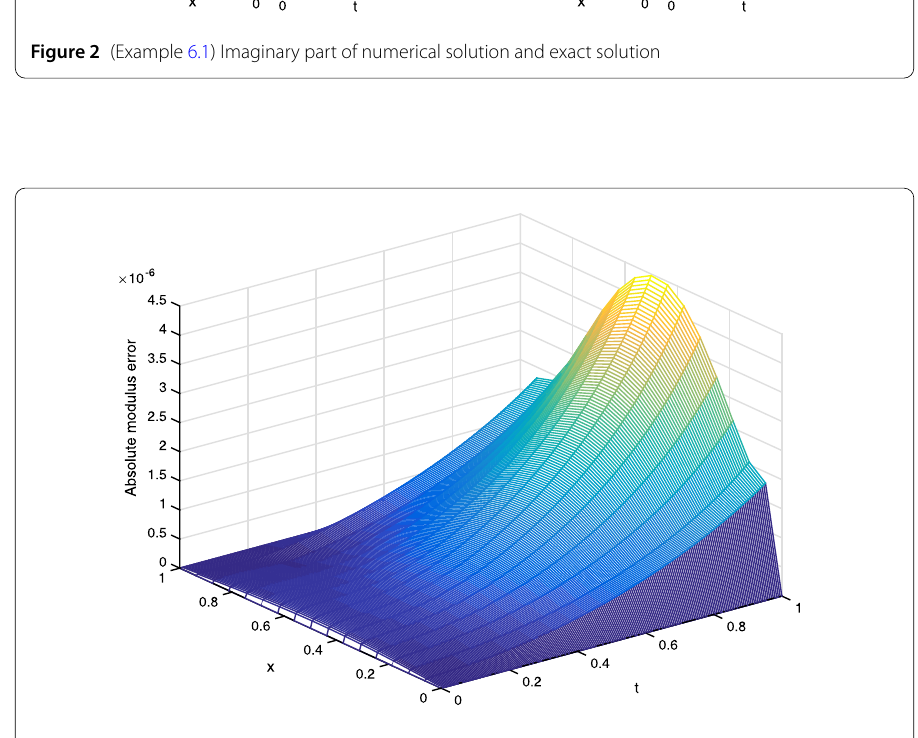
Figure 3 (Example 6.1) Absolute modulus